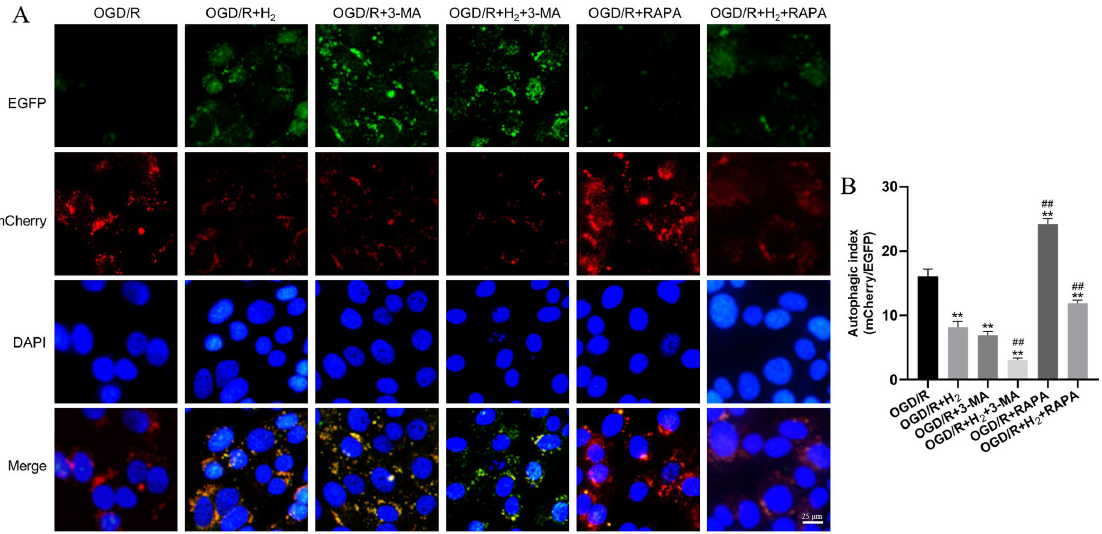
Figure 6. The changes of autophagic flux after OGD/R injury. ( A ) The mCherry-EGFP-LC3B reporter was transfected into HT22 cells for stable expression. ( B ) Quantifying the autophagic flow was achieved by comparing the mCherry+ puncta to the EGFP+ puncta (autophagic index). The mean autophagic index was plotted, with each data point corresponding to a field consisting of a minimum of 25 examined cells (Scale bar: 25 µ m). Data were reported using a mean and standard deviation format. A minimum of three separate repetitions of the experiments produced similar findings. ** p < 0.01 vs. OGD/R group. ## p < 0.01 vs. OGD/R+ H 2 group.